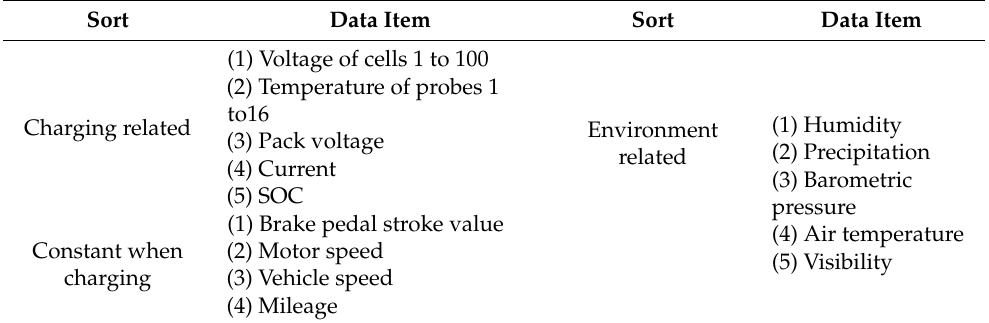
Table 1. The data items collected from the EV.